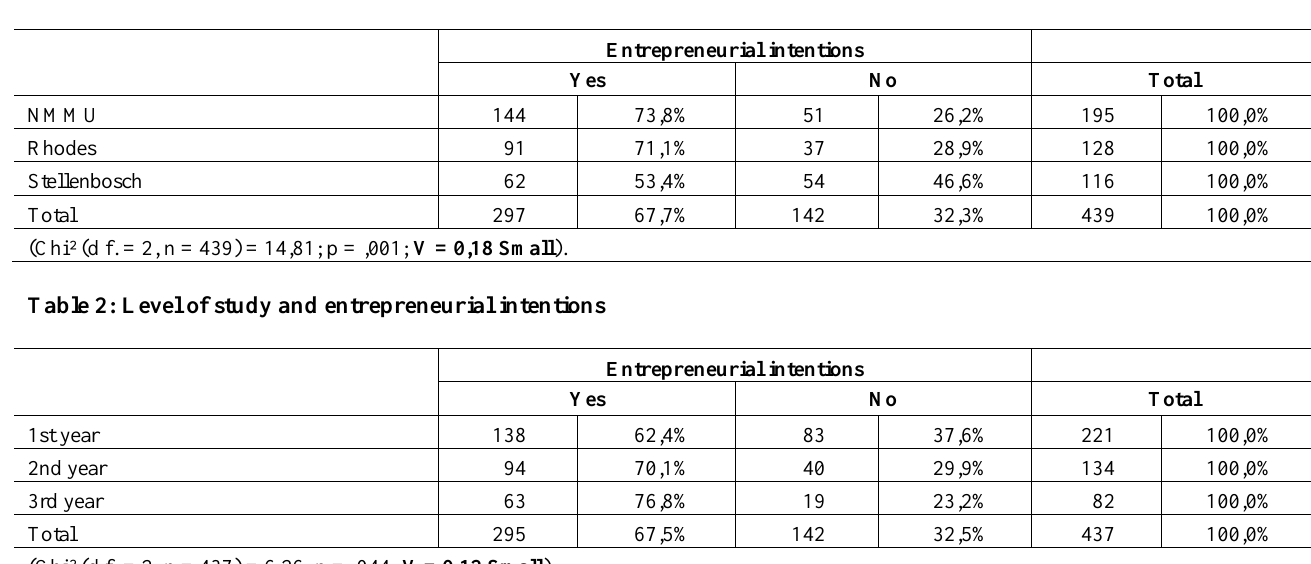
Table 1: University attended and entrepreneurial intentions